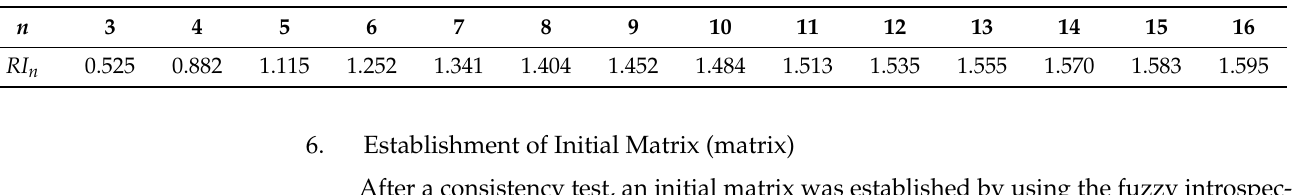
Table 1. Randomized index of RI n .